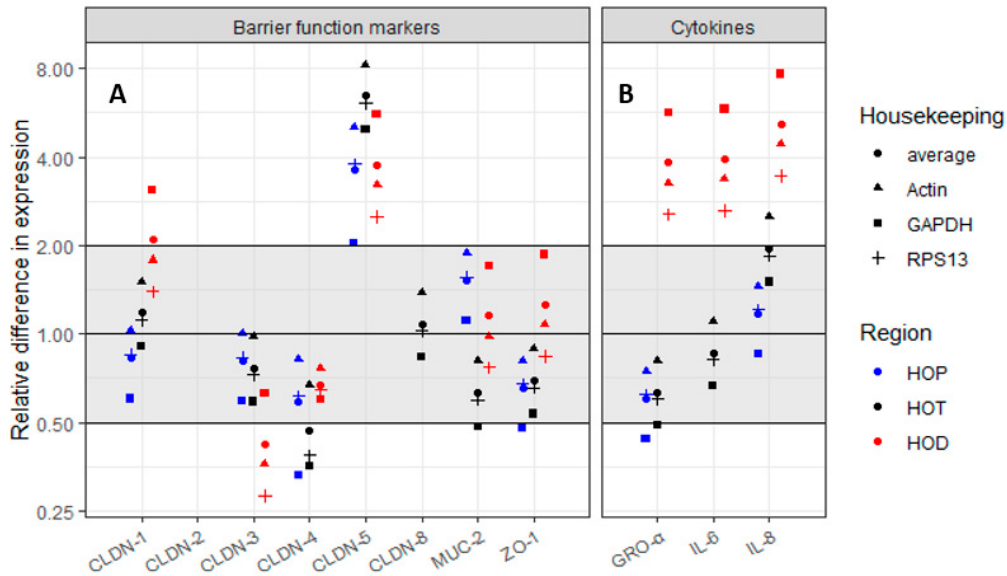
Figure 6. Effect of the f-HMO treatment on gene expression of barrier function proteins of the gut-on-chip. ( A ) Effect of 32 h treatment with f-2’FL on gene expression of barrier function proteins of proximal (HOP), transverse (HOT), and distal gut-on-chips (HOD); ( B ) Effect of 32 h treatment with f-2’FL on gene expression of cytokines and chemokines. Data are shown using 2^( −∆∆ Ct) method. Actin, GAPDH, and RPS13 were used as reference genes to normalize the data. CLDN-2 was not expressed in any of the three gut-on-chips. CLDN-8 expression could not be determined in HOP and HOD, and IL-6 in HOP.